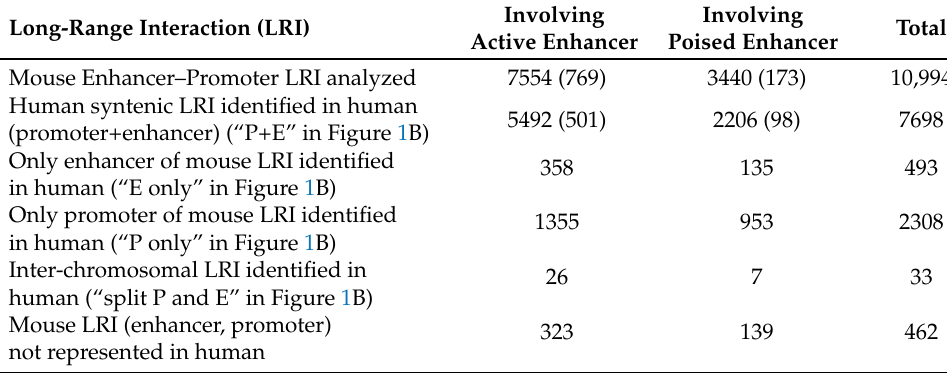
Table 1. Human DNA regions identified by their synteny with mouse enhancer–promoter long- range interactions previously identified by RNApolIIChIA-PET . Total number of mouse LRI con- necting promoter and enhancer anchors that were checked for syntenic conservation into the human genome (-minMatch = 0.5 for LiftOver). “Involving Active enhancers” and “Involving Poised en- hancers” report interactions in which the connected enhancer carries active and/or poised epigenetic enhancer marks (H3K27Ac, H3K4me1; see Figure 1). Numbers in brackets report the subset of the indicated LRIs which are redundant, i.e., those sharing more than 50% of length for both promoter and enhancer